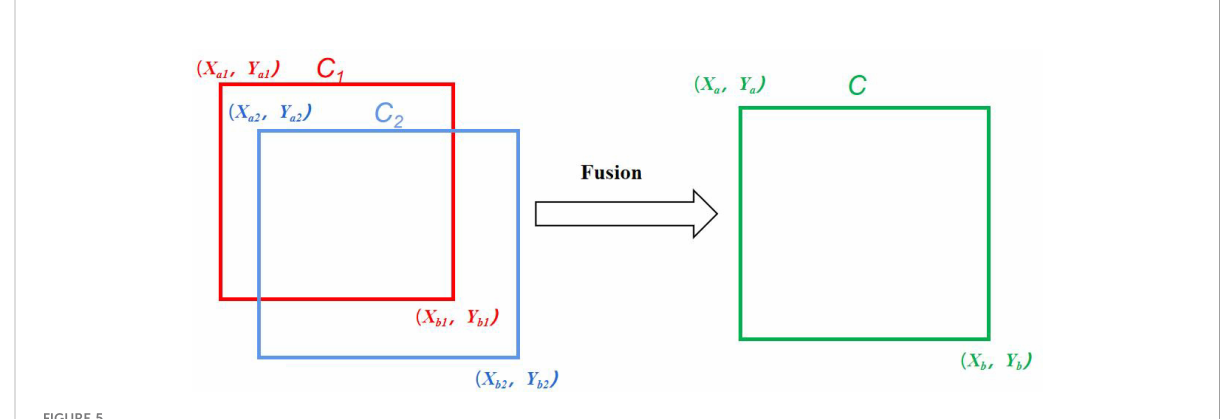
FIGURE 5 Principle of the weighted box fusion